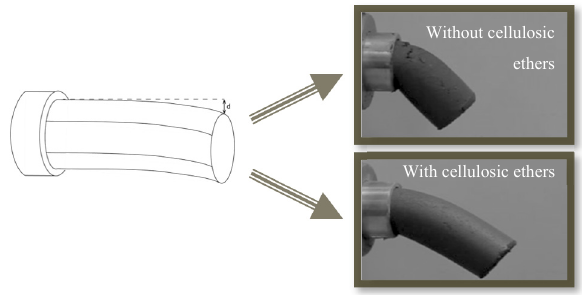
Figure 1. Examples of pictures extracted from the video recording used for the measurement of the tip deflection of the beam d